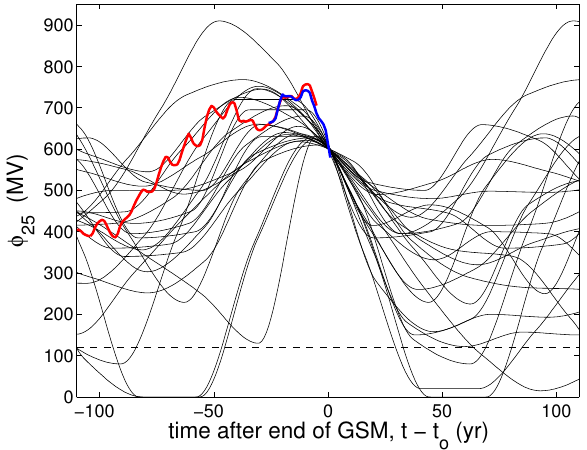
Figure 37: Update of the superposed epoch plot by Barnard et al. (2011). The black lines are the 25-year means of the heliospheric modulation potential 𝜑 25 derived from ice-core 10 Be abundances by Steinhilber et al. (2008) and here interpolated to annual values using splines interpolation: these are composited around the 24 times 𝑡 = 𝑡 𝑜 in the 9300-year record that 𝜑 25 fell below the 600 MV level. The horizontal dashed line in the Maunder minimum value, 𝜑 MM . The blue line shows 22-year running means of 𝜑 derived from monthly-mean Oulu neutron monitor data with 𝑡 𝑜 = 2001 . 4 (when 𝜑 22 fell to 600 MV). The red line shows 22-year running means of the reconstruction of annual 𝜑 values, as derived by Usoskin et al. (2002) for the same 𝑡 𝑜